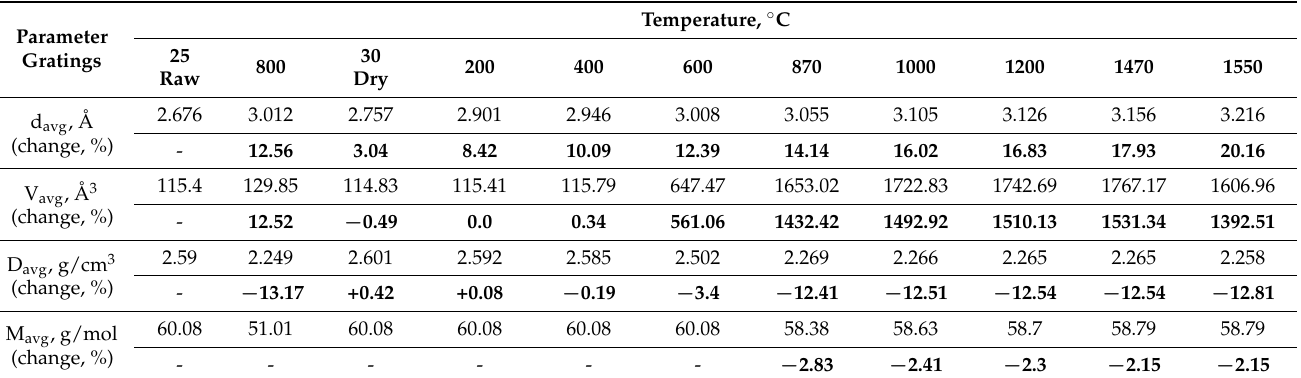
Figure 8. The X-ray diffraction patterns of quartzite: ( a ) taken at 870 °C; ( b ) removed at 1550 °C. The averages of the lattice parameters—interplanar distance (d avg ), volume of the unit cell (V avg ), density (D avg ) and molecular weight (M avg )—obtained from studies of quartzite calcined at a temperature of 800 °C, cooled to ambient temperature and subsequently heated from 30 to 1550 °C, were determined on the basis of the obtained interplanar distances for each diffraction pattern, and they are given in Table 5. Table 5. The results of the study of quartzite calcined at a temperature of 800 °C, cooled to ambient temperature and subsequently heated from 30 to 1550 °C.